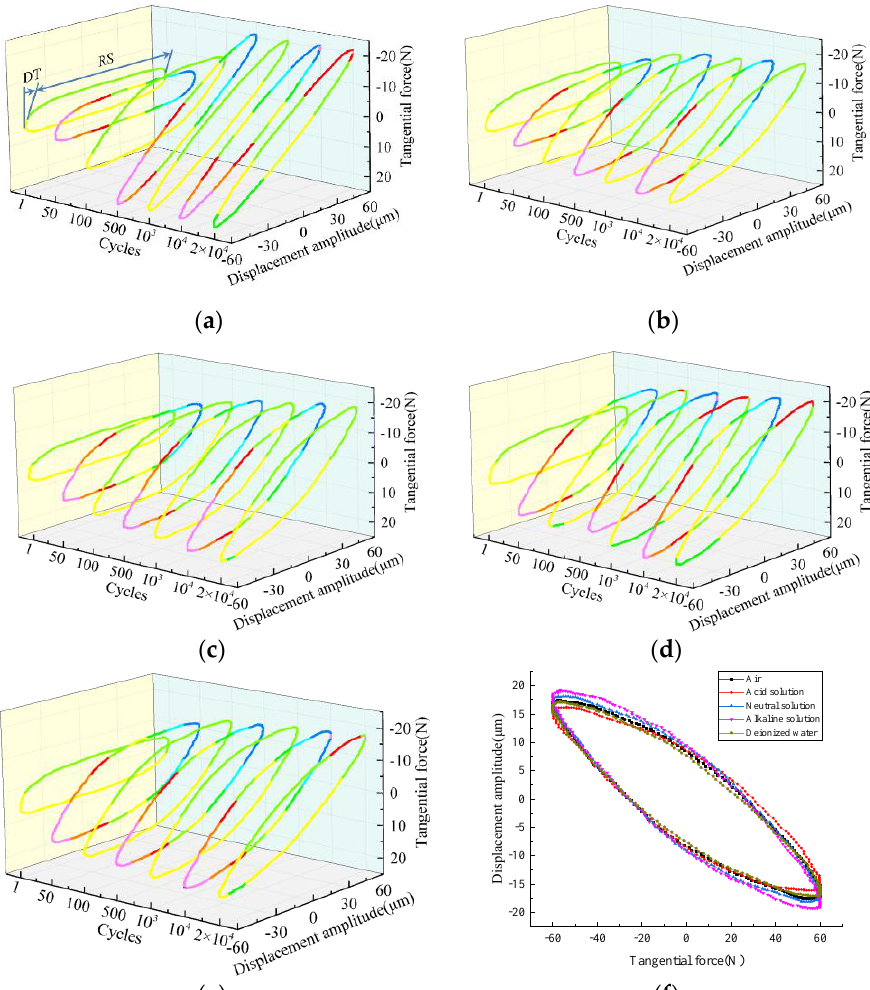
Figure 1. F t - D loops during tension–torsion cyclic loading of steel wires with fretting contact in di ff erent environmental media. ( a ) air; ( b ) acid solution; ( c ) neutral solution; ( d ) alkaline solution; ( e ) deionized water; ( f ) comparison of hysteresis loops at loading cycles of Table 3. The maximum tangential force and relative displacement at loading cycles 20,000 in different environmental media.